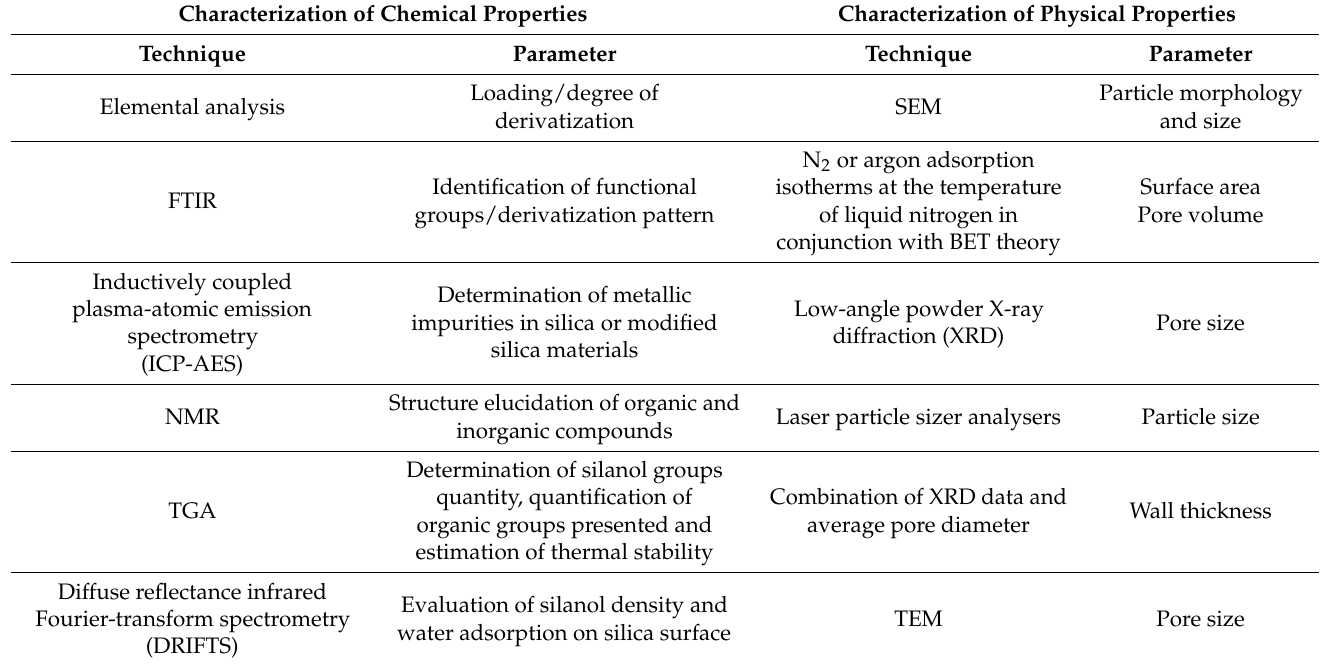
Table 1. Techniques for characterization of physical and chemical